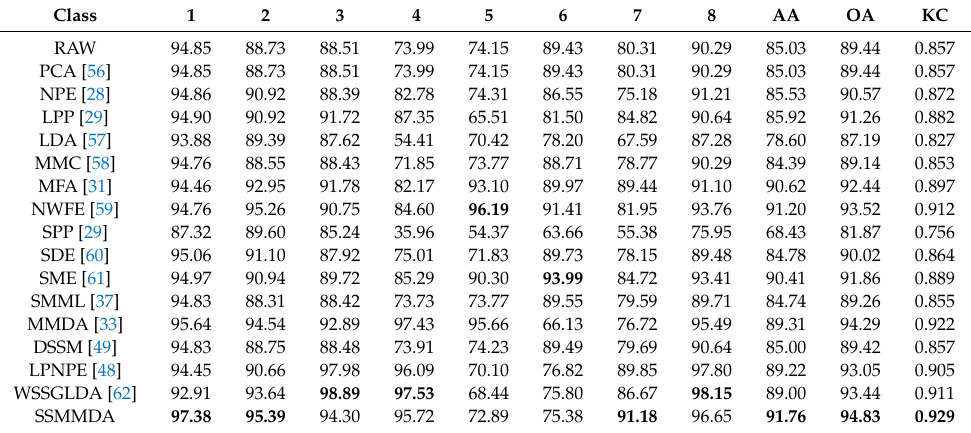
Table 5. Classification results (%) of each class (t = 0.1%) with NN classifier on the Heihe data